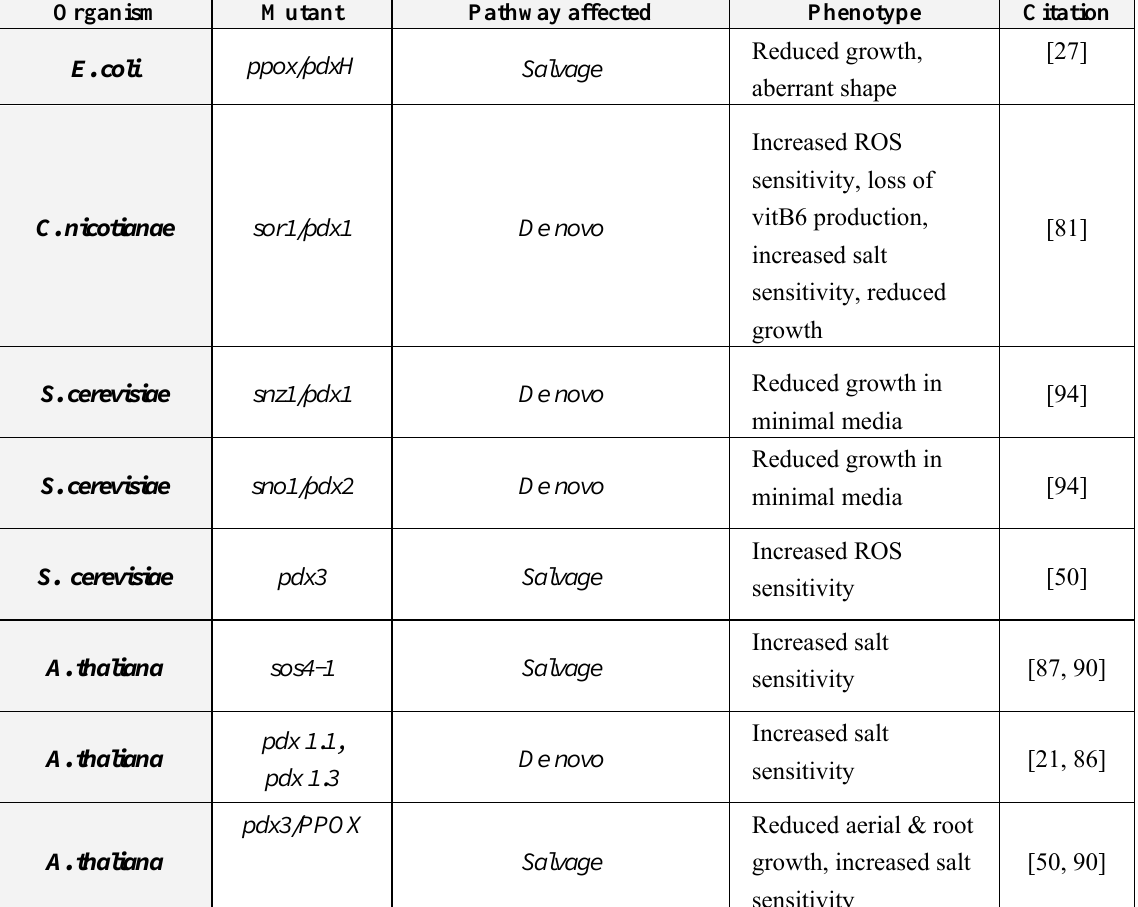
Table 1 . Examples of VitB6 De Novo and Salvage Pathway Mutants in Context with